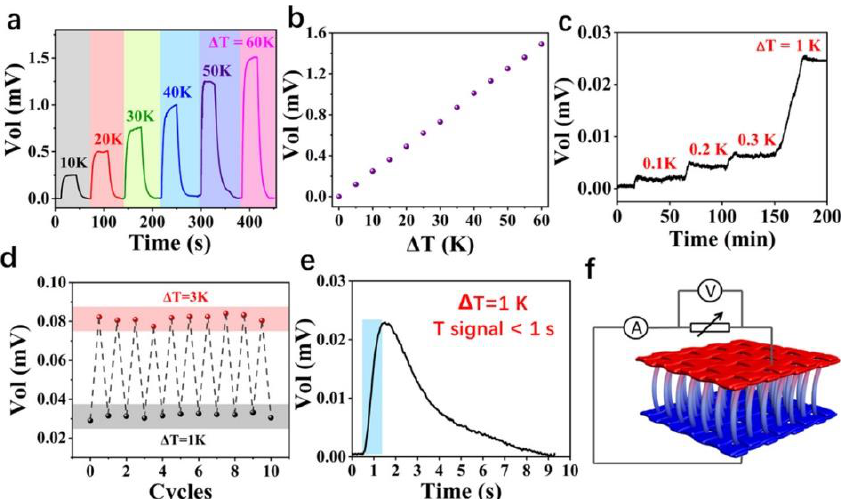
Figure 3. Temperature-sensing performance of fiber-based thermoelectric devices. Reproduced with permission from Ref. [30]. Copyright © 2020, American Chemical Society. ( a ) The relationship between the output voltage and ΔT. ( b ) The Seebeck coefficient of the thermoelectric device is simulated from the Voltage- ΔT curve. ( c ) The temperature response resolution is as small as 0.1 °C. ( d ) The temperature sensor is a stable temperature response. ( e ) The response time of temperature sensing. ( f ) The temperature-sensing mechanism.